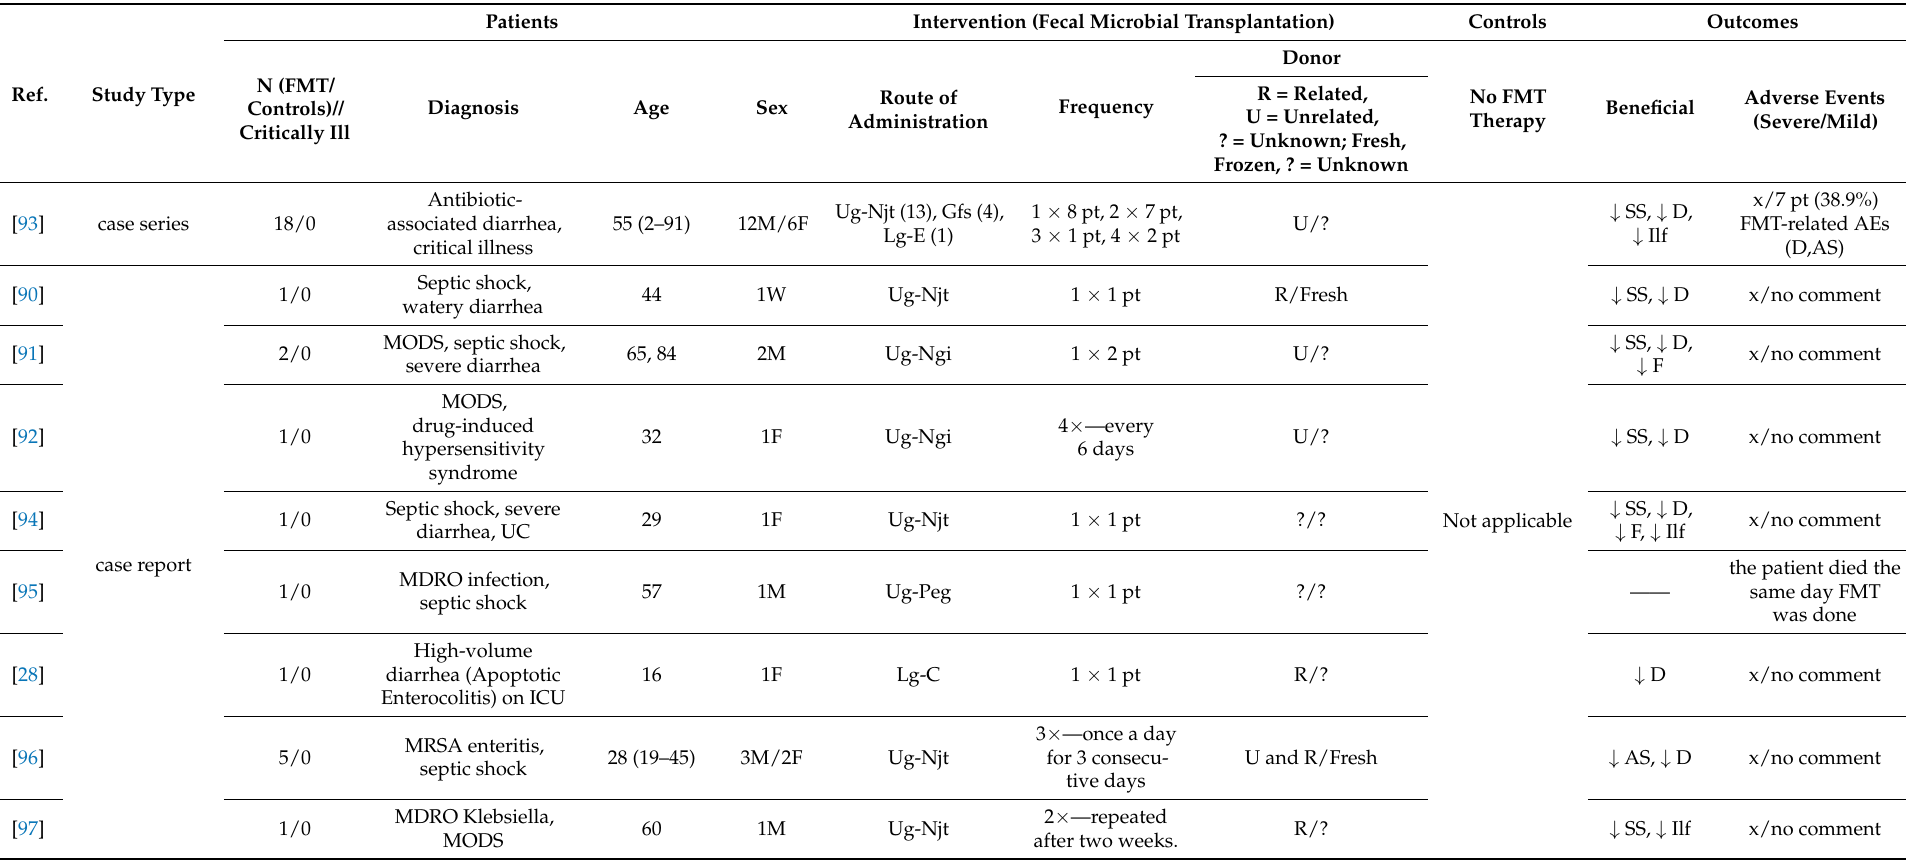
Table 3. Clinical studies on critically ill patients with sepsis and septic